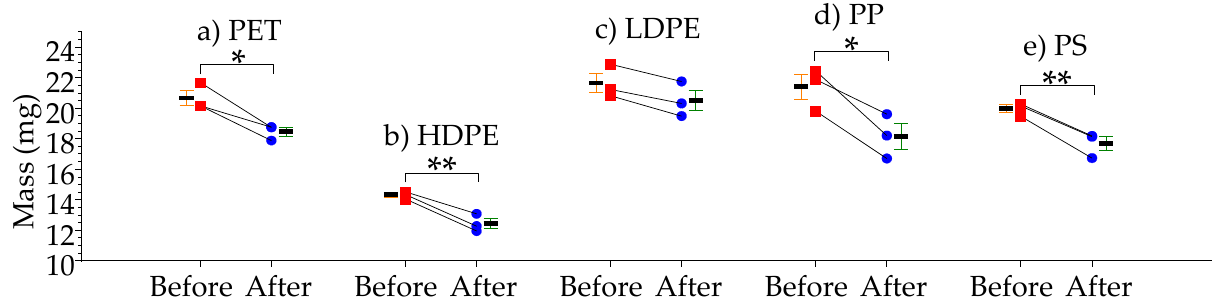
Figure 4. Mass change of five different types of model plastics and paired t -test analysis for each model microplastic sample of three repeats in V = 10 mL with 0.27 M potassium persulfate (K 2 S 2 O 8 ) and V = 10 mL of 0.24 M sodium hydroxide (NaOH) solution at T = 20 ◦ C for t = 24 h. The mean mass loss percentage (shown as short black bar) for ( a ) PET, ( b ) HDPE, ( c ) LDPE, ( d ) PP and ( e ) PS were 10.7, 13.2, 5.2, 15.1 and 11.4%, respectively. Error bars are standard deviation ± mean of experimental values. Solid points show the actual values of each datum, and the long thin black lines are the connection of the same samples before and after the treatment. * = p < 0.05, ** = p < 0.01.